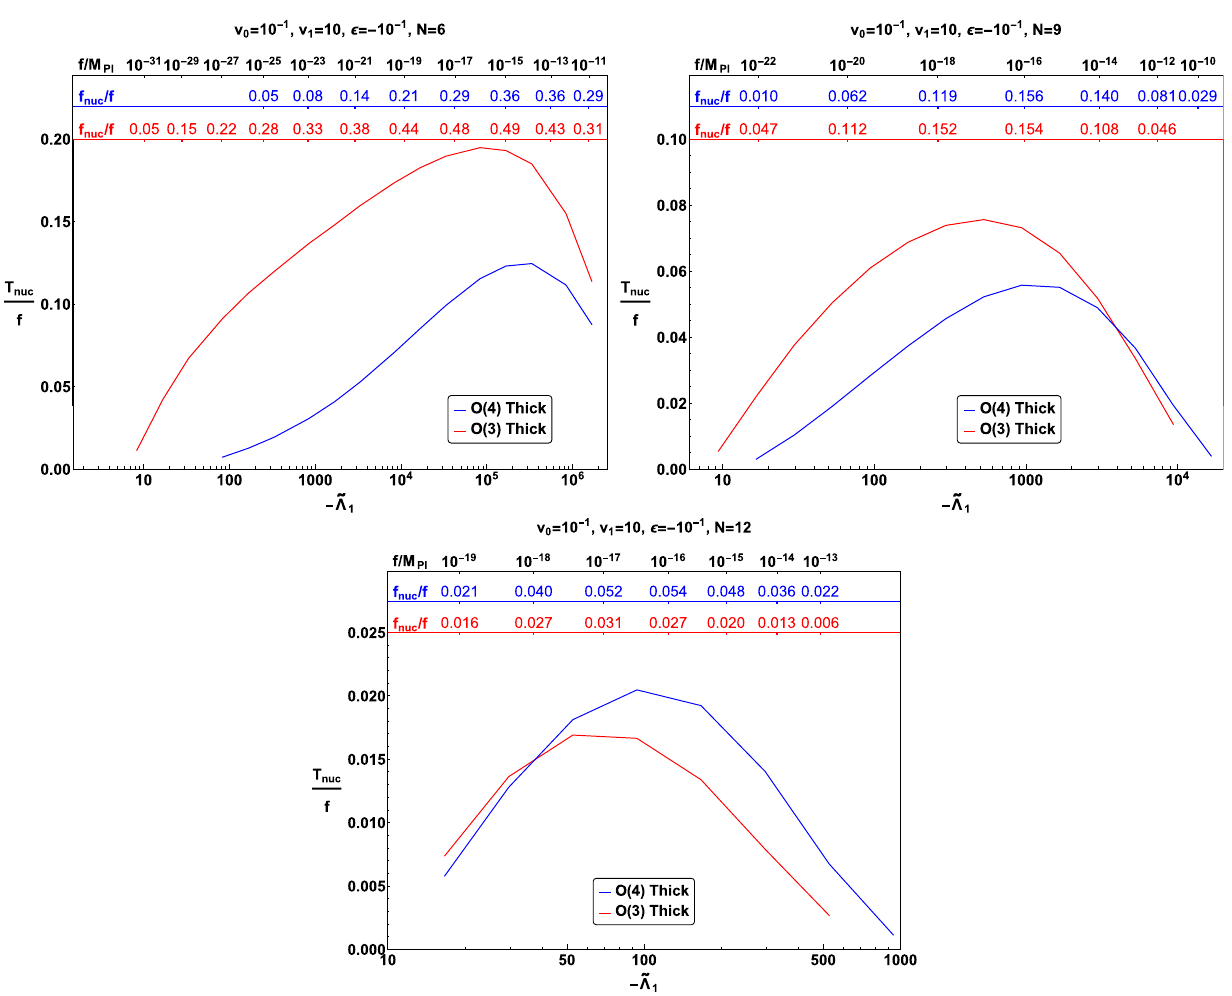
Fig. 7 Theseplotshowsthenucleationpropertiesforthesoftwallwith v = 10 , and various values of N . Both the temperature at which nucle- 1 ation occurs and the value of f nuc tunneled to are displayed, along with